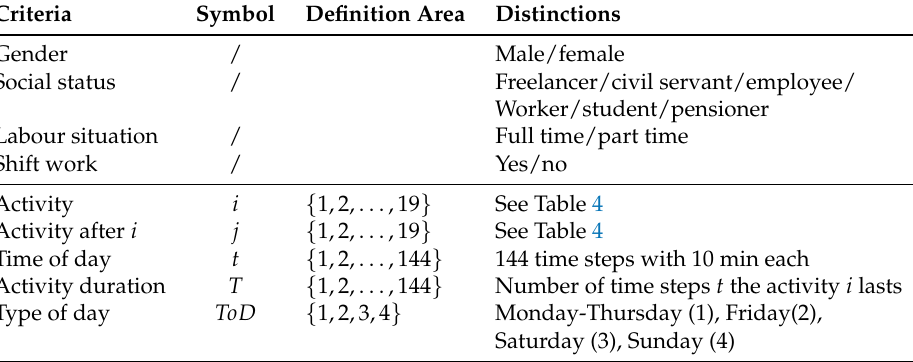
Table 3. Criteria to filter the time-use study representative for Germany (Zeitverwendungserhebung) (ZVE) data.